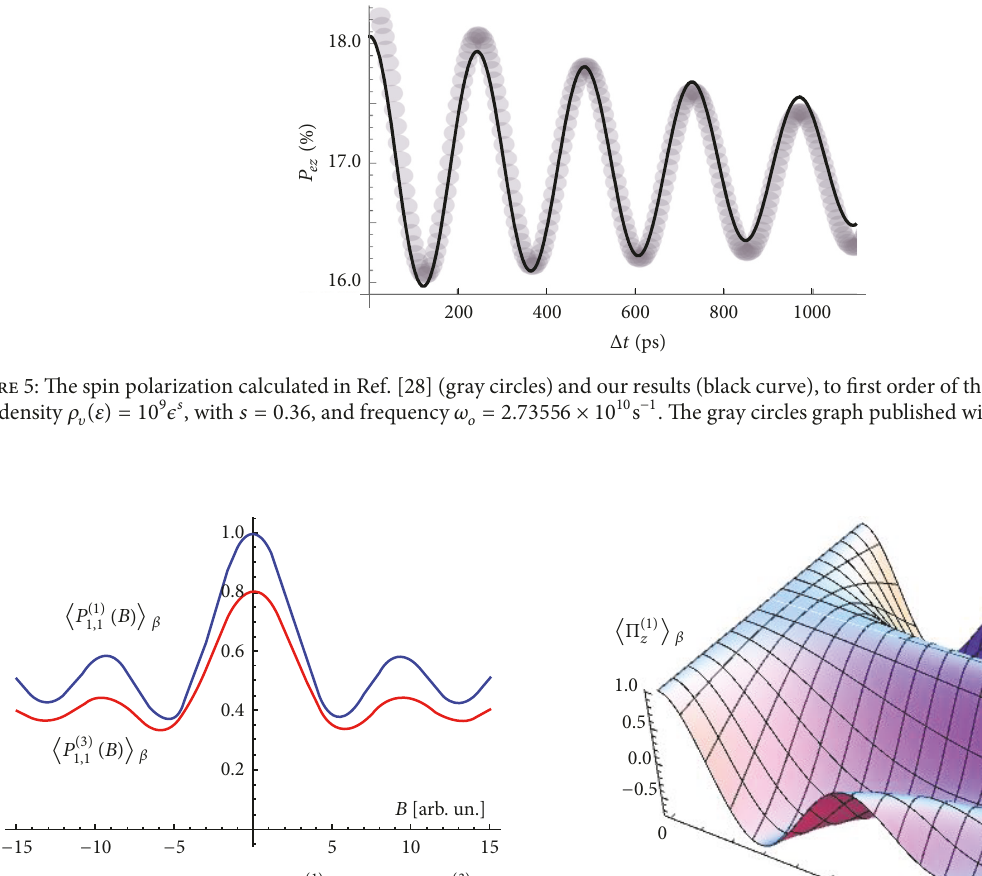
Figure 6: The survival probabilities ⟨𝑃 (1) 1󳨀→1 (𝑡)⟩ 𝛽 and ⟨𝑃 (3) 1󳨀→1 (𝑡)⟩ 𝛽 at 𝑡 = 1.2 × 10 −9 , 𝑇 = 300 K and 𝜌 = 𝜖 𝑠 × 10 9 s −1 , with 𝑠 = 0.2 .